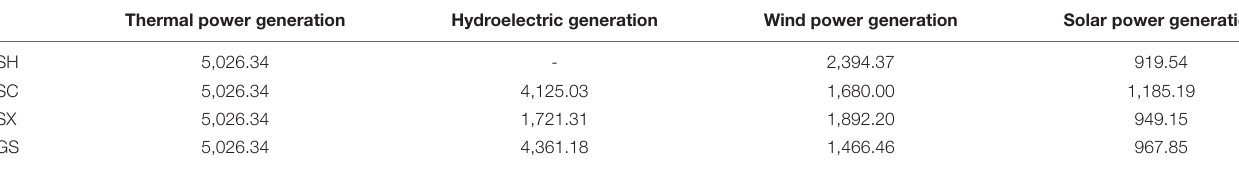
TABLE 2 | Annual available time of electricity-generation facilities (h).